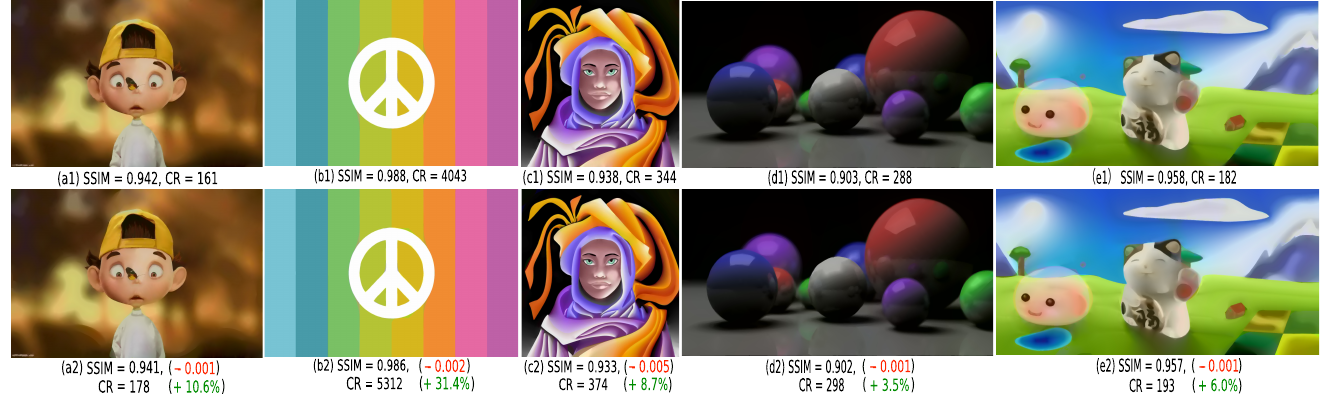
Figure 8. A comparison of the SDMD method for five images without Y-structures removal ( a1 – e1 ) and with this scheme used ( a2 – e2 ). For each image, we show the SSIM quality and compression ratio CR. We also indicate what we lost (in red) and what we gained (in green) in CR and SSIM when using the Y-removal